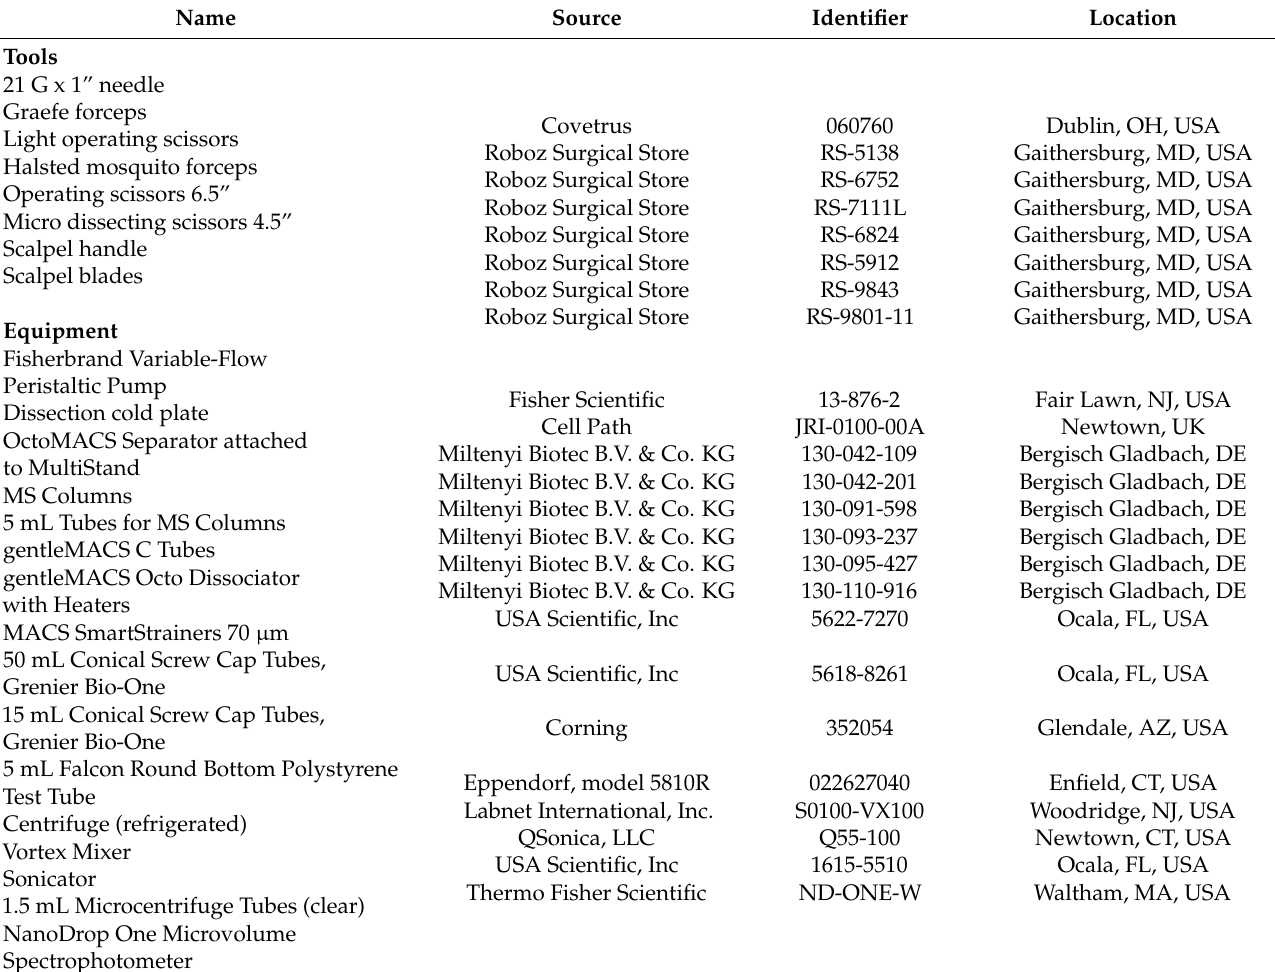
Table 2. Detailed information on tools and equipment.